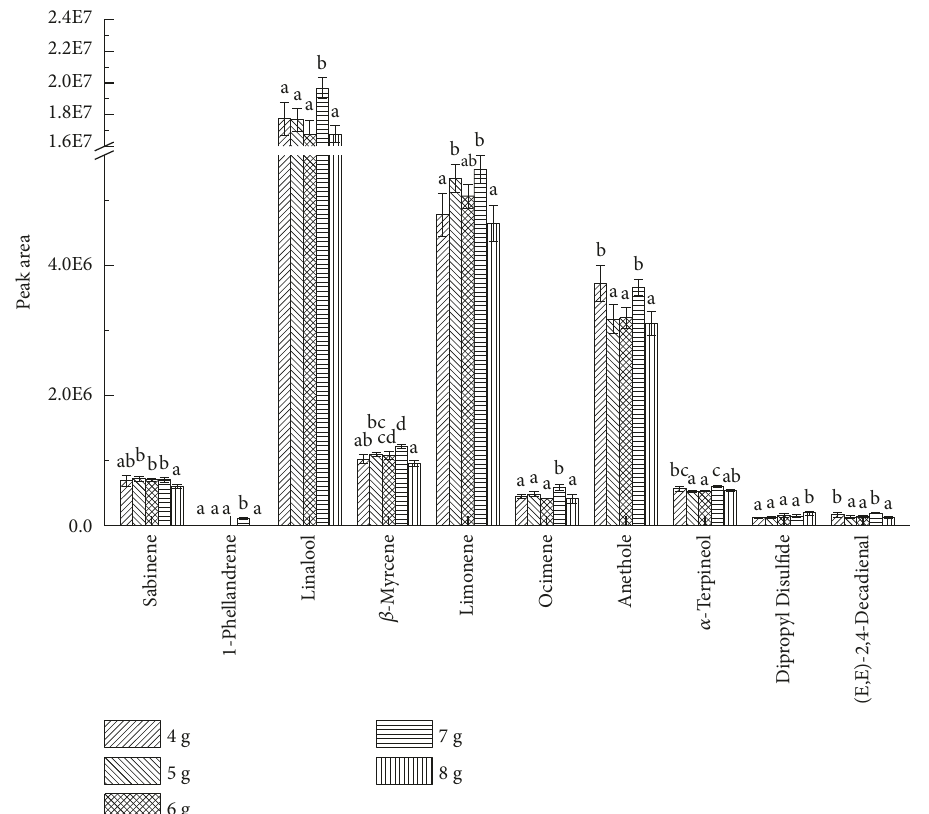
Figure 5: Effects of different sample volume on peak areas of key aroma compounds. English letters “a”, “b”, “c”, “d” indicate Duncan’s multiple range test among peak areas of the five sample volumes. Data in the same compound marked with different letters mean significant difference ( p < 0.05) and the same letters denote not significant difference (p < 0.05).